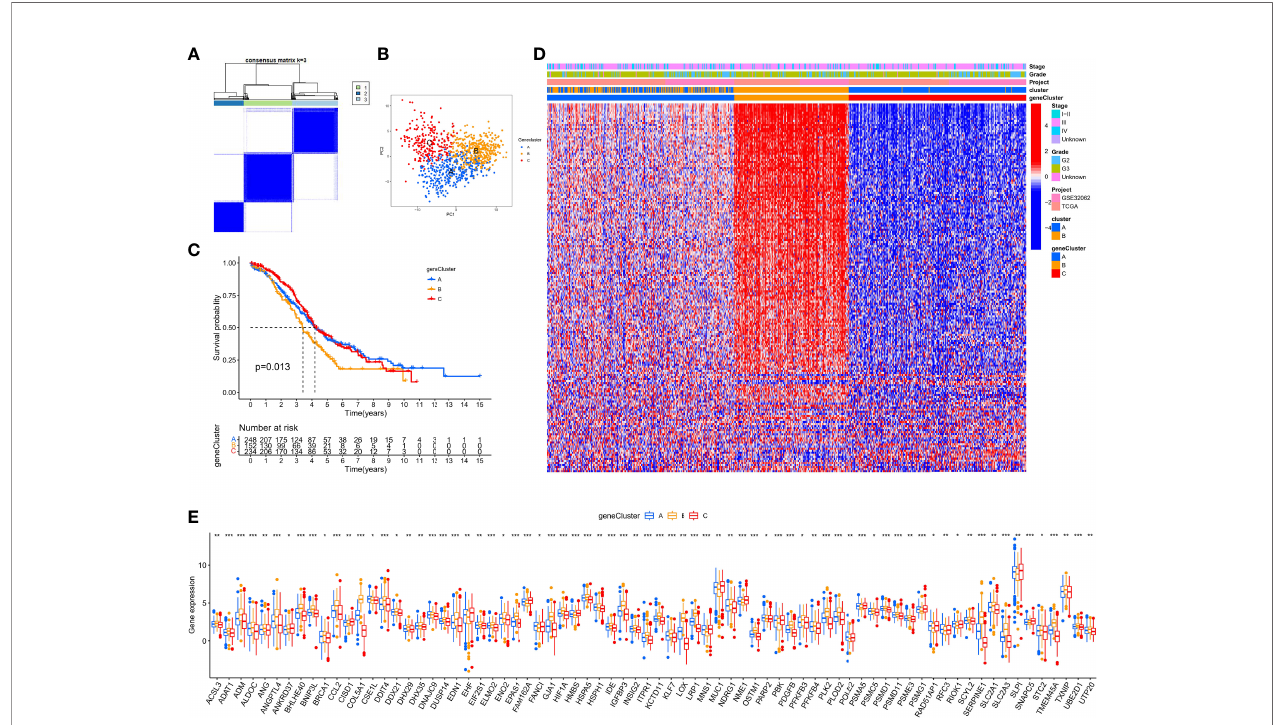
FIGURE 5 | Hypoxia pattern-related regulator subtypes. (A) Heat map of unsupervised clustering analysis. (B) PCA analysis of different gene subtypes. (C) Kaplan – Meier analysis of overall survival time in different gene subtypes. (D) Heat map of distribution of clinicopathological characteristics and three gene subtypes. (E) Box plot of 140 sHRGs in three subtypes. *p < 0.05, **p < 0.01, ***p <